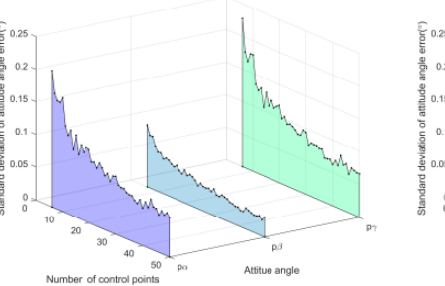
( c ) Depth of control points 200–500 m Figure 13. SDLE vs. number of control points. 4.2. Performance with Respect to Angle Noise Level An experiment was conducted to evaluate the accuracy with respect to different an- gle noises. The number of control points is 50. The depth of the control points is 50–100, 100–200, and 200–500 m. Both azimuth  and pitch  are in the range [20,70] . Gauss- ian noise with 0 mean and standard deviation